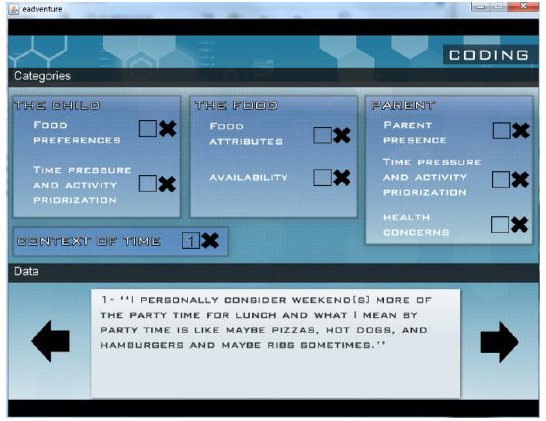
Figure 4. An example of the data and categories for the coding